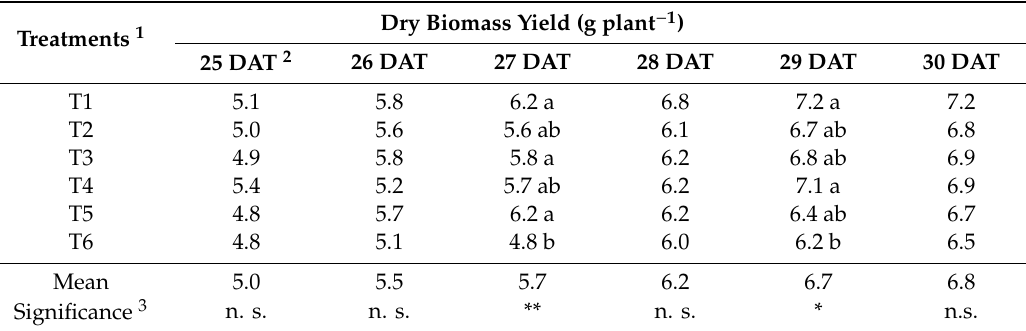
Table 6. Spring trial: dry biomass yield of lettuce per type of fertilization treatment. Treatments 1